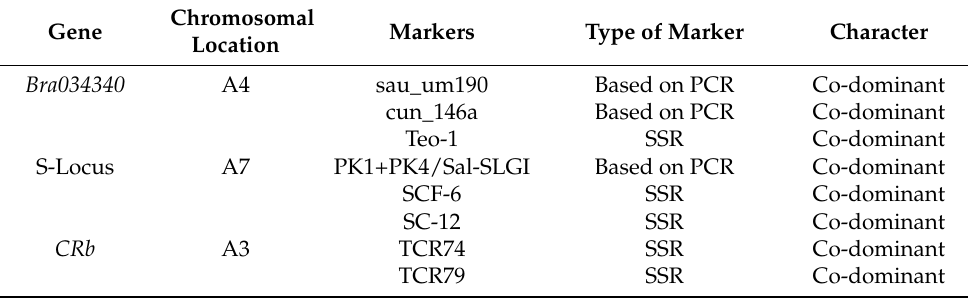
Table 1. Molecular marker information for foreground selection of three targeted loci.